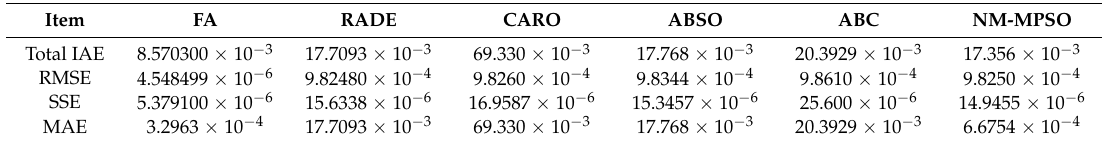
Table 8. Statistical result for double diode model (RTC France Company).